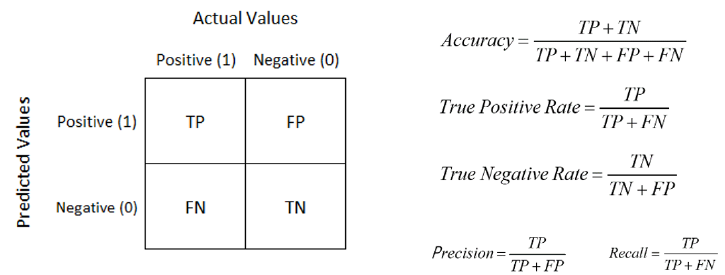
Figure 6. Confusion matrix and performance measurement formulas.